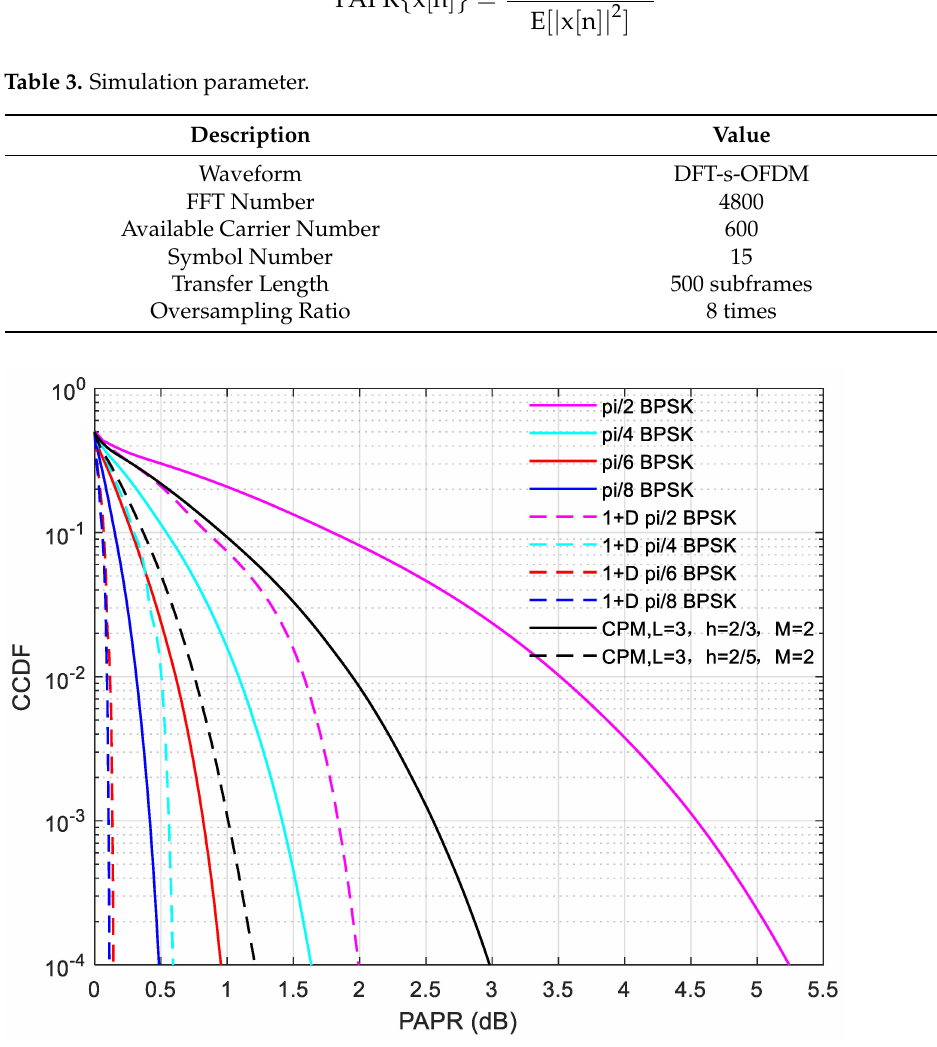
Figure 3. PAPR comparison of different modulation schemes under